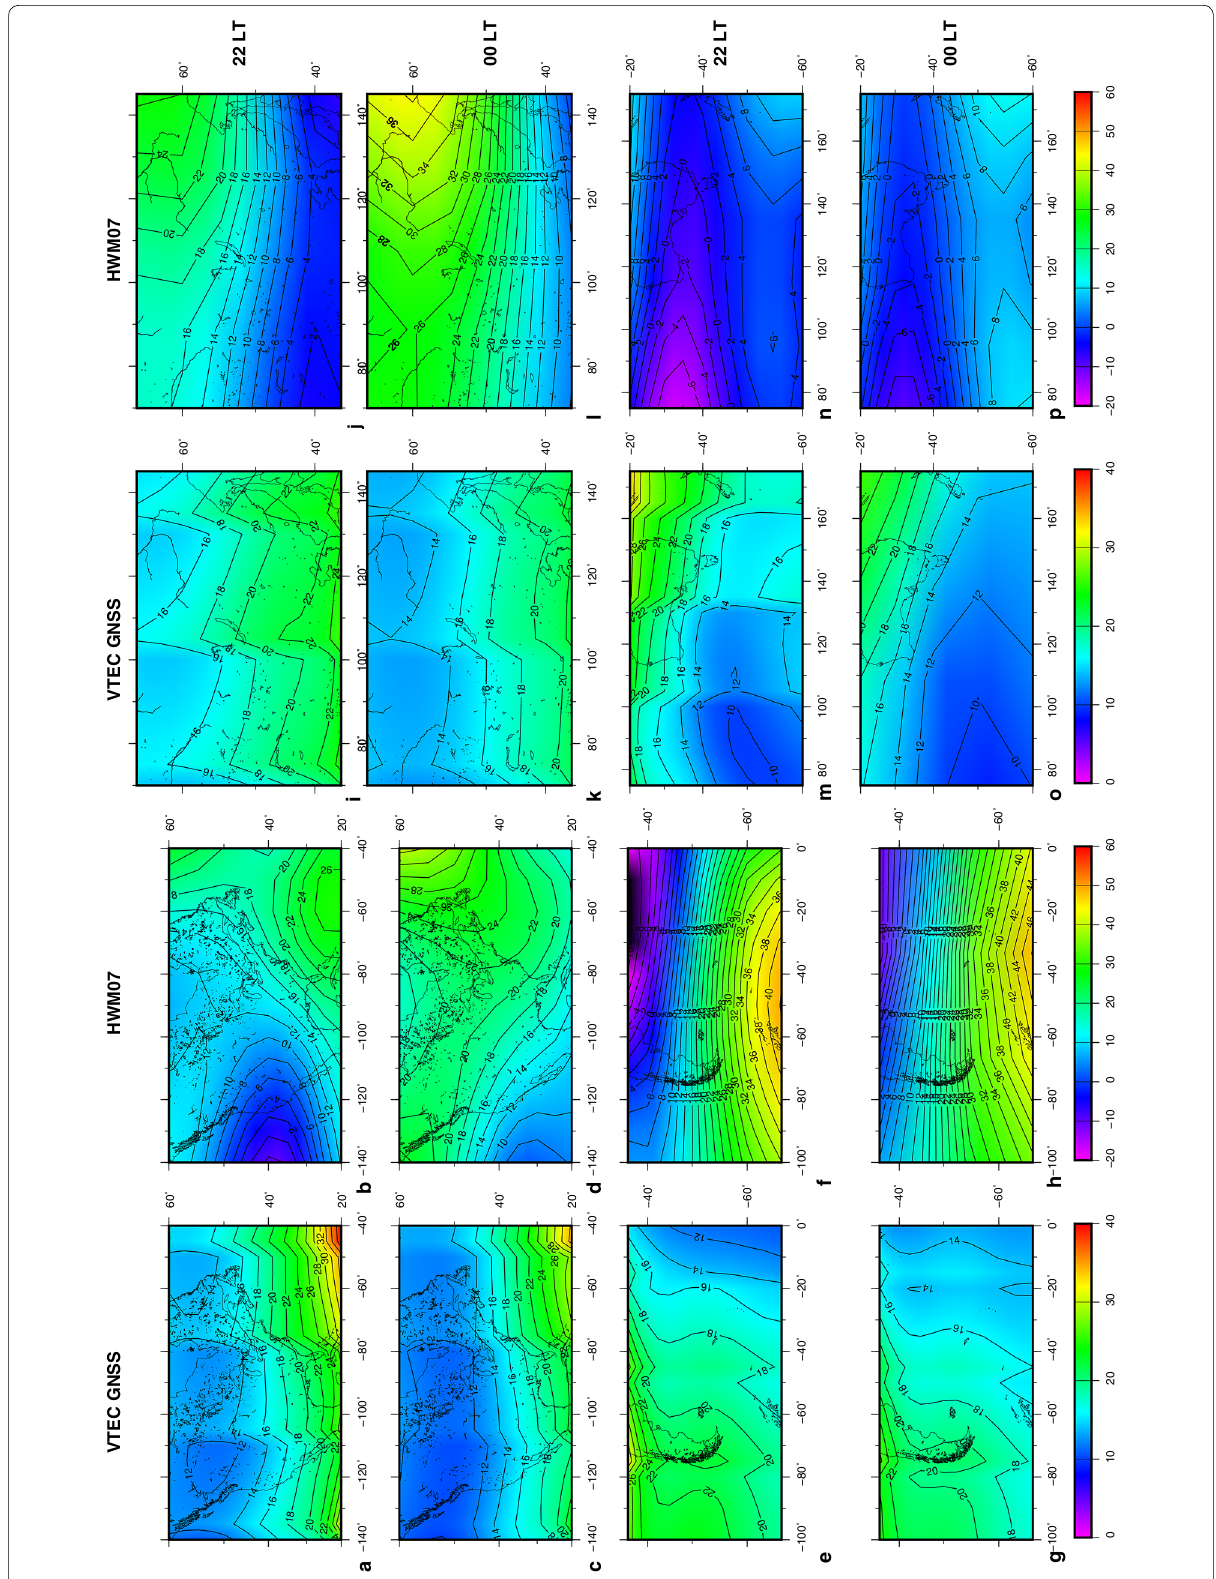
Fig. 2 Average values of vTEC GNSS for each region at 22 LT (panels a , e , i and m ); at 00 LT (panels c , g , k and o ). Average values of V HWM07 for each region at 22 LT (panels b , f , j and n ); at 00 LT (panels d , h , l and p